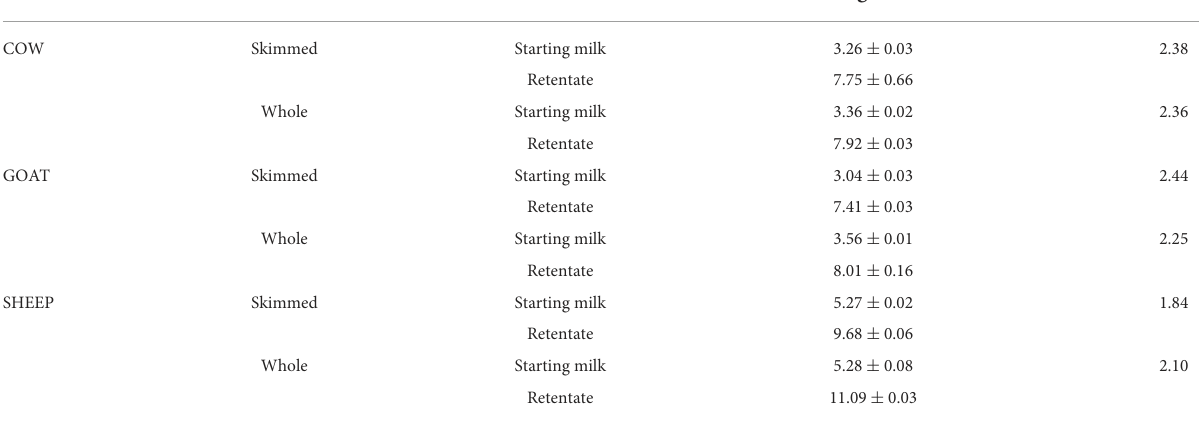
a EachvalueisobtainedfromtwoUFperformedondifferentdaysandduplicateKjeldahlanalysis. b PCF,ProteinConcentrationFactor.